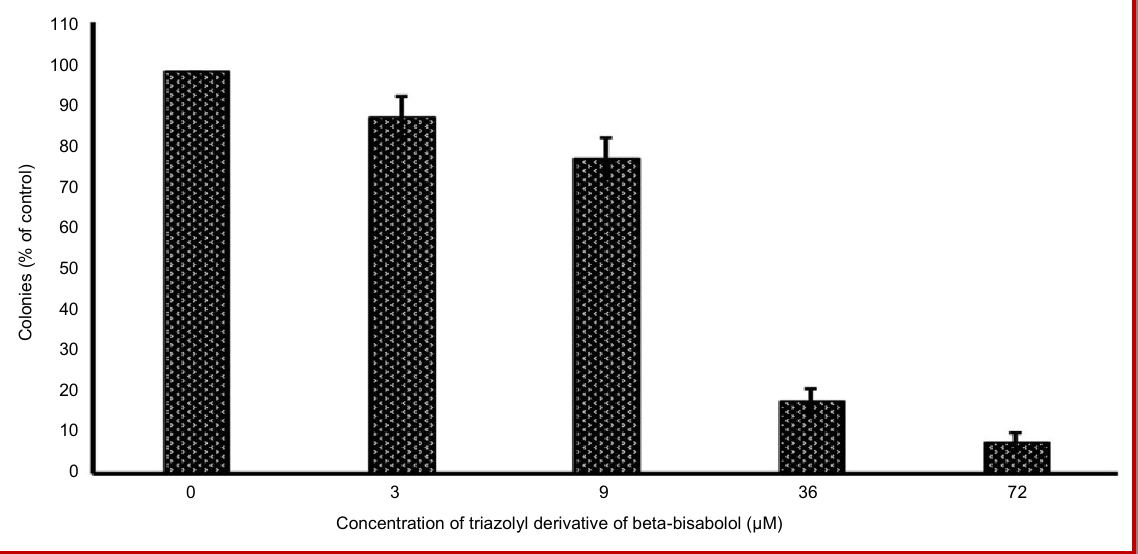
Figure 3: Inhibitory effect of triazolyl derivative of beta-bisabolol on the growth and multiplication of human cervical cancer cells (ME-180). The colony formation assay of ME-180 cells treated with TTB at indicated